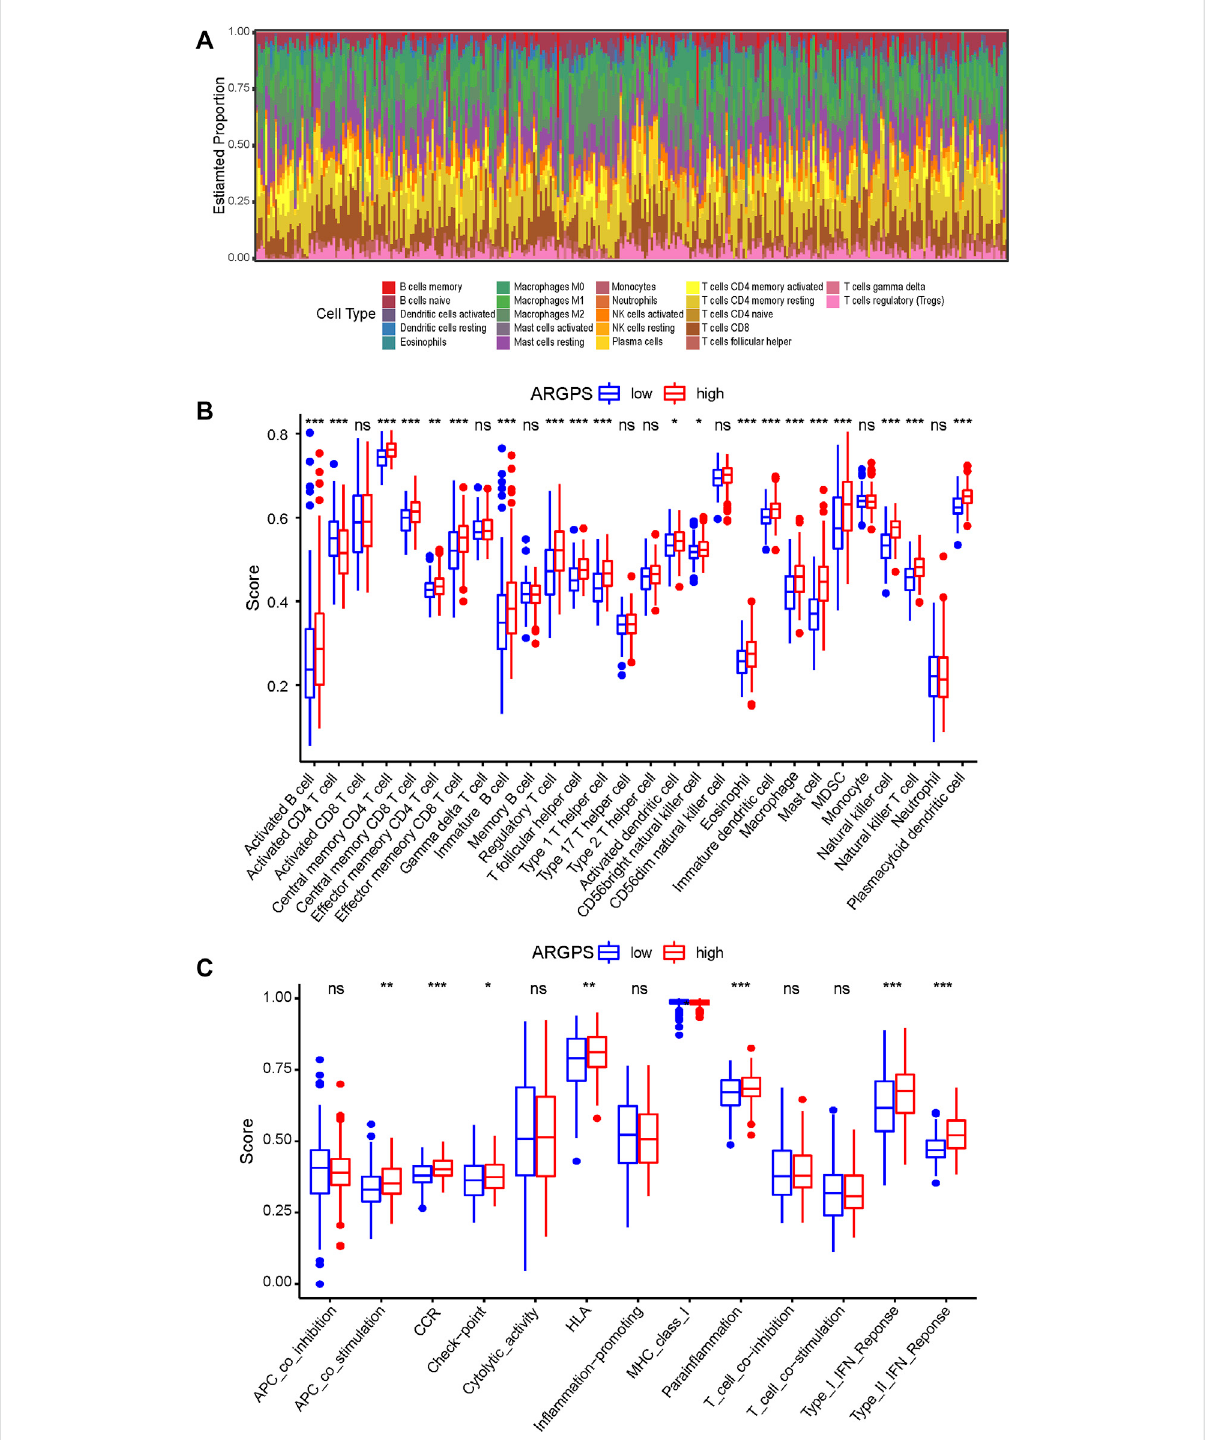
FIGURE 7 Evaluation of the immune microenvironment of gastric cancer. (A) The proportion and distribution of 22 immune cells in each sample of the TCGAcohortwerecalculatedbytheCIBERSORTalgorithm.Thesumofallestimatedcellscoresineachsampleis1.Thedifferenceof (B) 28immune cells and (C) 13 immune pathways in fi ltration levels between the high- and low-risk groups compared by the ssGSEA analysis. ns > 0.05, * < 0.05, ** < 0.01, *** < 0.001. TCGA, The Cancer Genome Atlas; ssGSEA, Single-sample Gene Set Enrichment